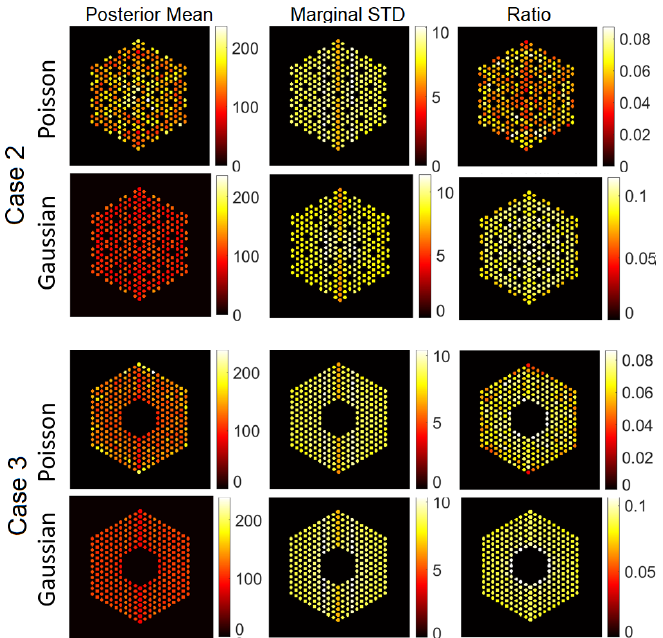
Figure 12. The IDEAL response matrix: Pin pixels averaging of the proposed approach for Case “2” and Case “3”. ( Left-hand column ): posterior mean, ( middle column ): marginal standard deviation, and ( right-hand column ): the ratio of marginal standard deviation divided by posterior